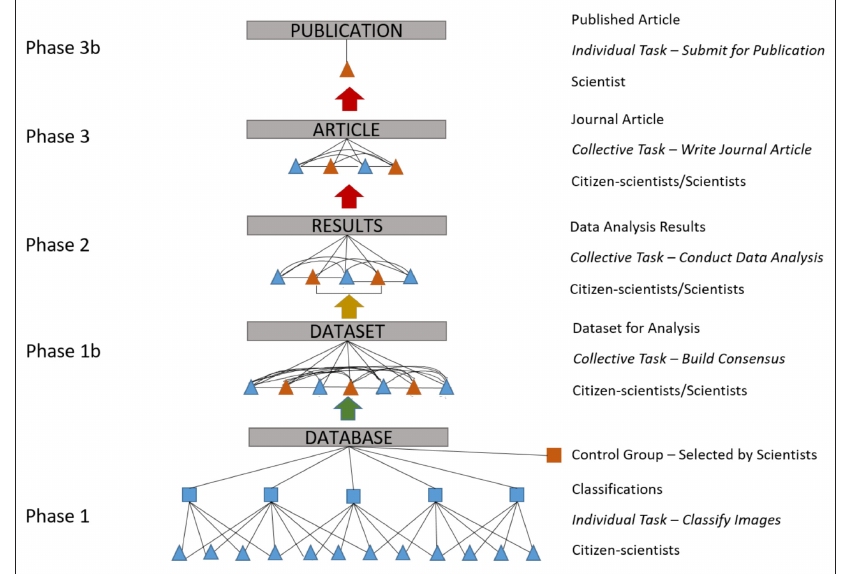
Figure 5: Expected structure of dependencies in Galaxy Zoo Quench (data flow from the bottom